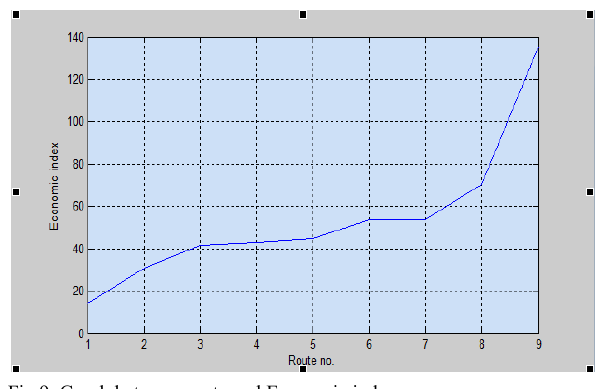
Fig 9. Graph between route and Economic index